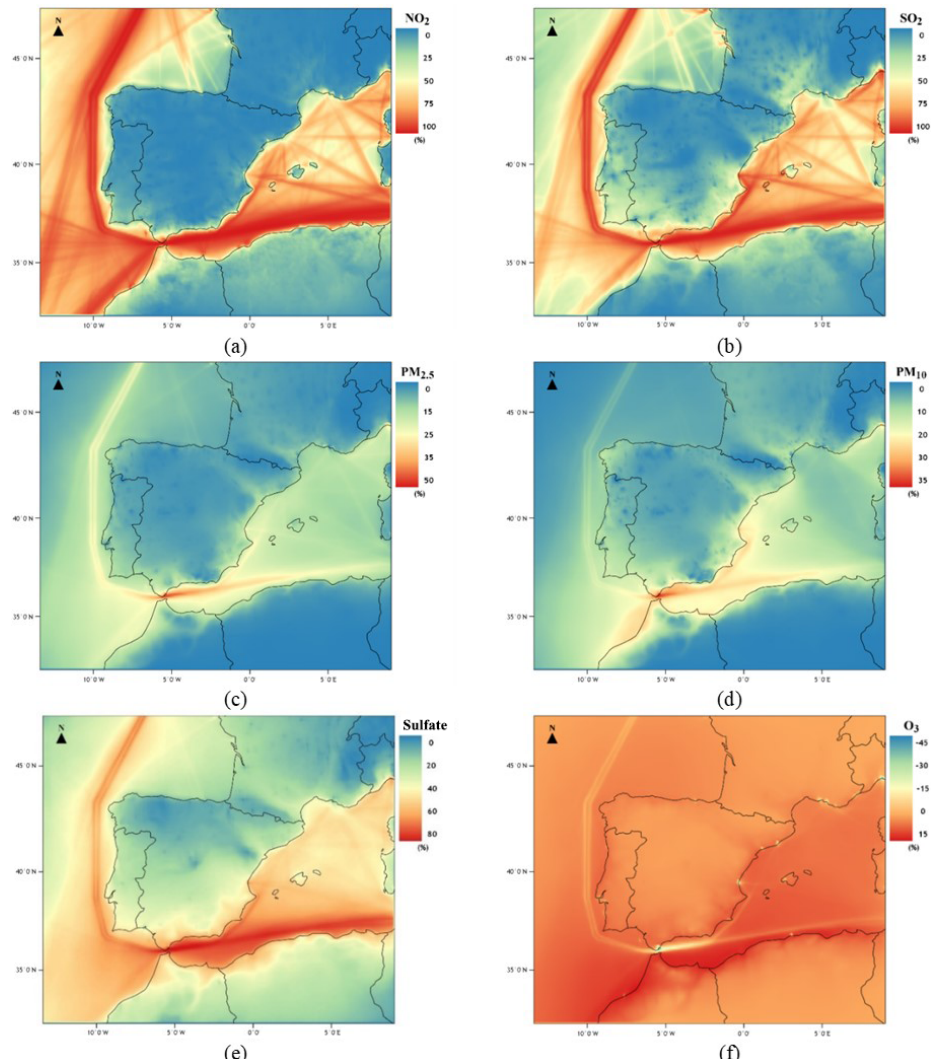
Figure 4. Contribution of shipping emissions (%) to annual mean concentrations of (a) NO 2 , (b) SO 2 , (c) PM 2 . 5 , (d) PM 10 , (e) sulfate, and (f) O 3 for